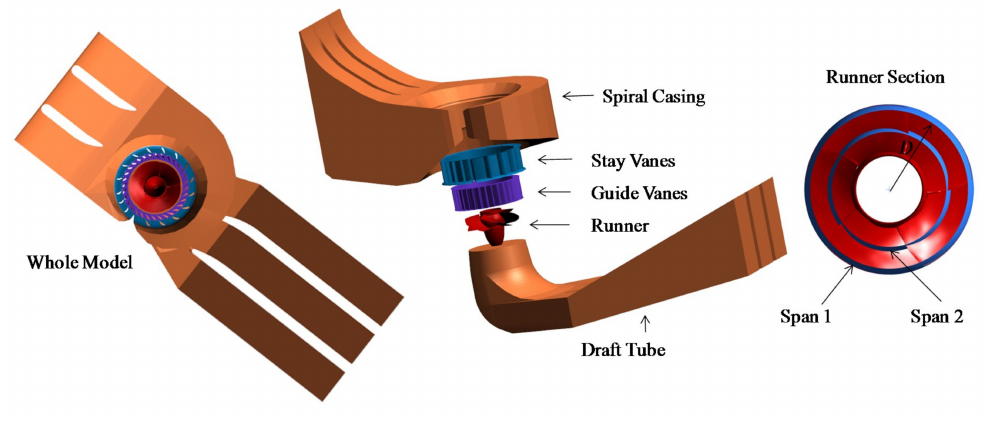
Figure 2. Sketch of the entire computational domain for the Kaplan turbine